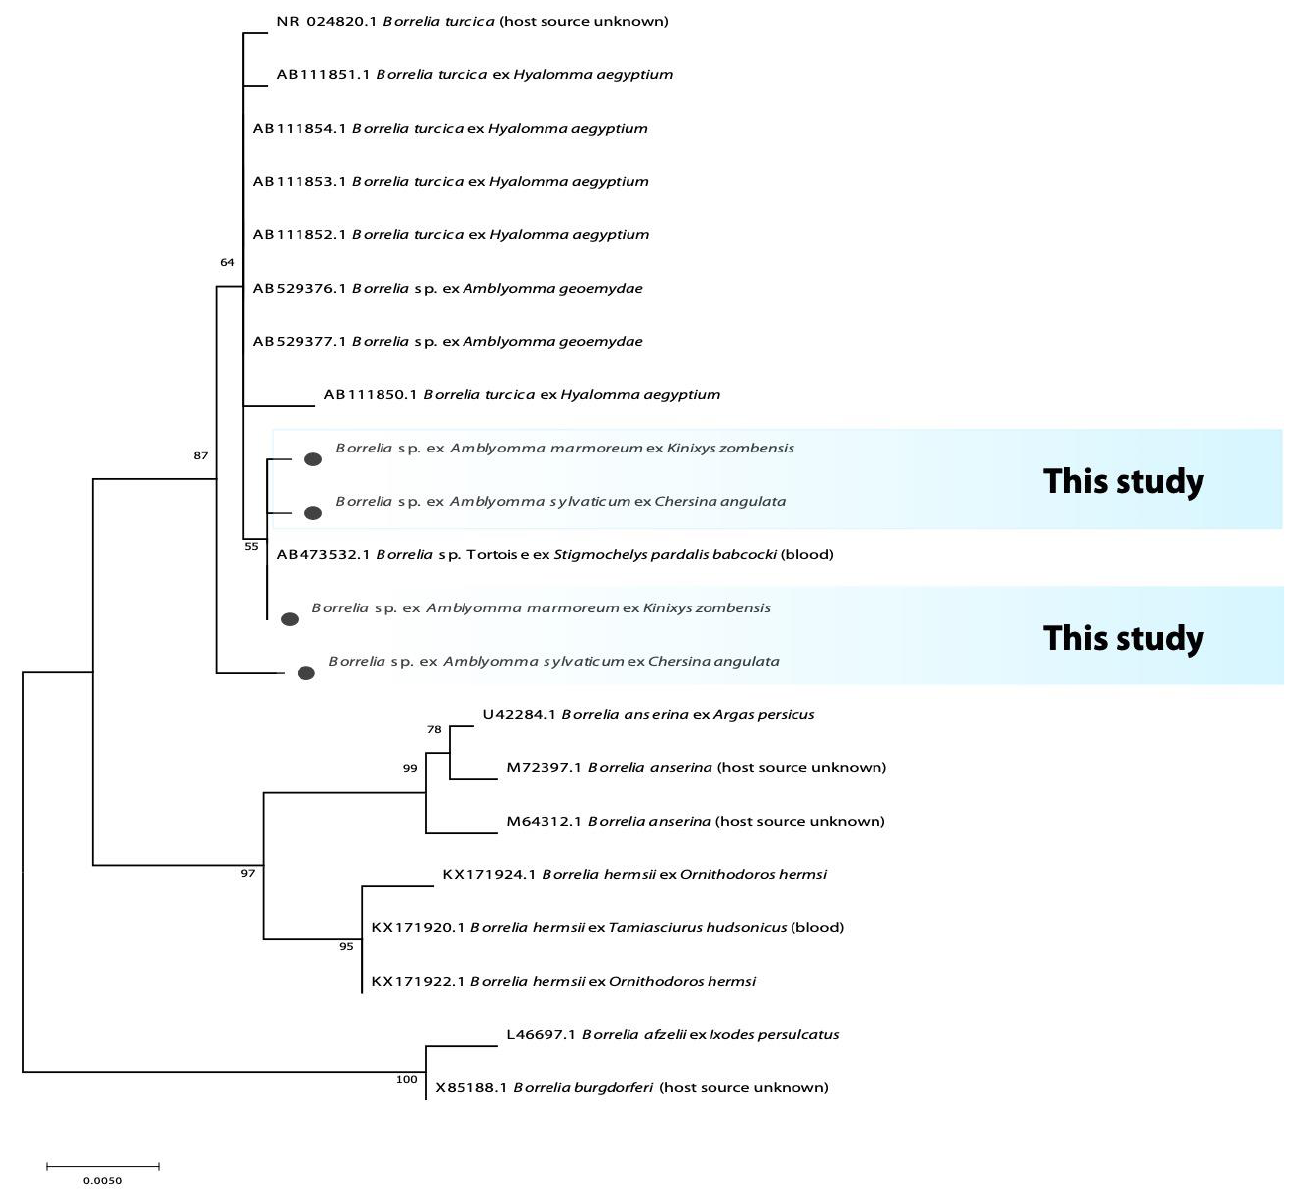
Figure 1. Phylogenetic tree based on the sequences of the Borrelia 16S rRNA gene. The tree was constructed using MEGA 11 based on the maximum likelihood, using the Hasegawa-Kishino-Yano Model. The sequences obtained in this study are indicated with bullets.